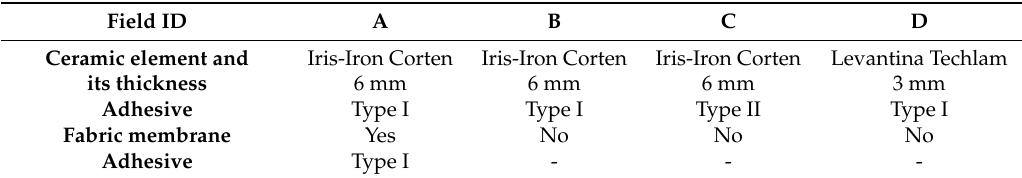
Table 1. An overview and composition of the test fields.